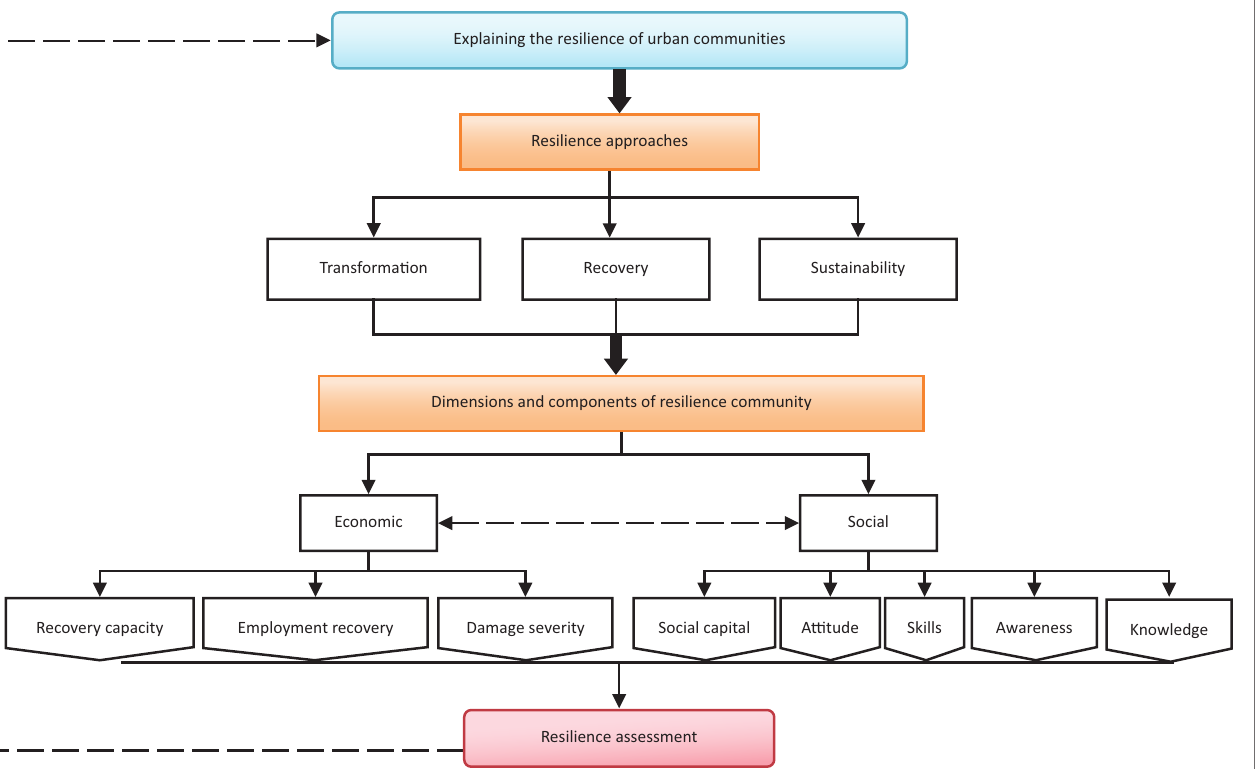
Explaining the resilience of urban